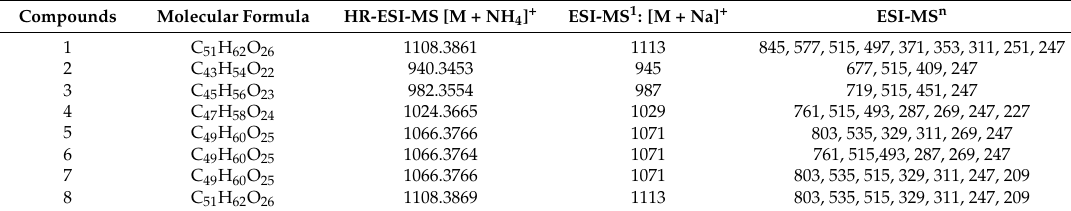
Table 3. HR-ESI-MS and key ESI-MS n data of the isolates 1 – 8 .